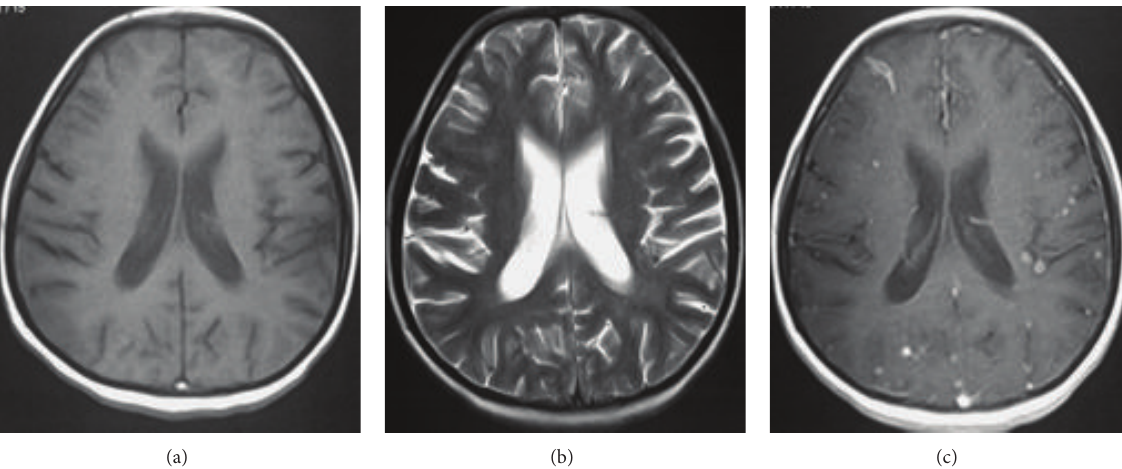
Figure 7: Miliary brain tuberculosis in a 20-year-old female with 3-month history of cough, weight loss, newly added generalized headache, dizziness, nausea, and vomiting. There is no obvious abnormality in the T1- (a) and T2-weighted (b) images. Axial postcontrast T1-weighted MR image (c) shows numerous bilateral tiny enhancing nodules scattered throughout the brain